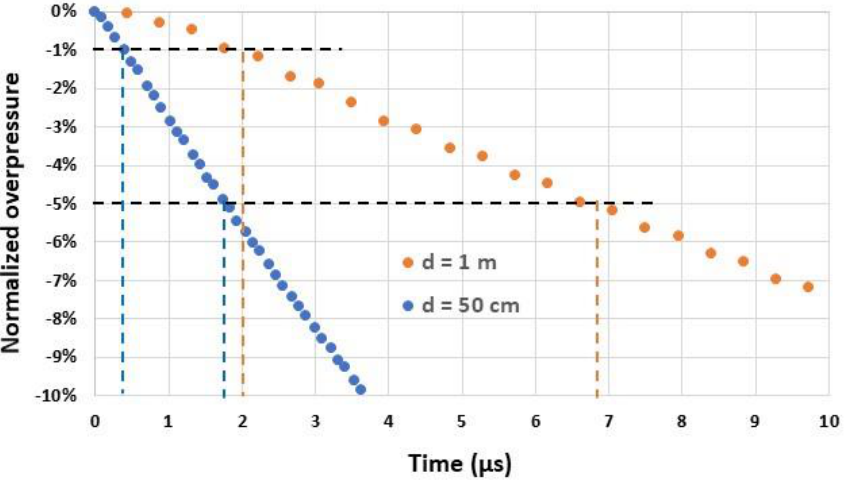
Figure 3. Normalized overpressure [( P r − P r − max ) / P r − max ] in the side-on configuration as a function of time t for two distances d (50 cm and 1 m) from an explosive charge of 1 kg of trinitrotoluene. At the origin t = 0, the overpressure reaches its peak value P r − max ( P r − max = 33.5 bar at a distance of 50 cm and 8.7 bar at 1 m). Table 2. Minimal response time required by the sensor to measure 𝑃 𝑟−𝑚𝑎𝑥 with the required accu- racy.